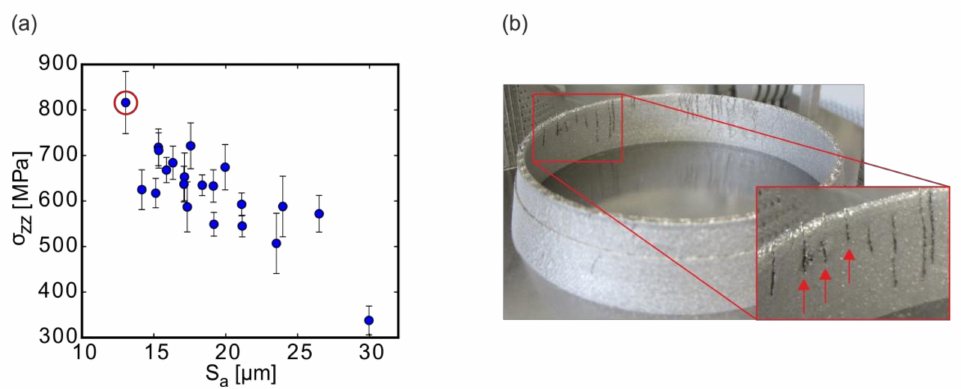
Figure 14. Correlation of the mean arithmetic height S a with ( a ) the stress in build direction σ zz and ( b ) image of a component (diameter ~80 mm, height ~15 mm) built with the same parameters that were used for sample #19 and exhibited severe RS-induced cracking. Three examples of cracks are indicated by red